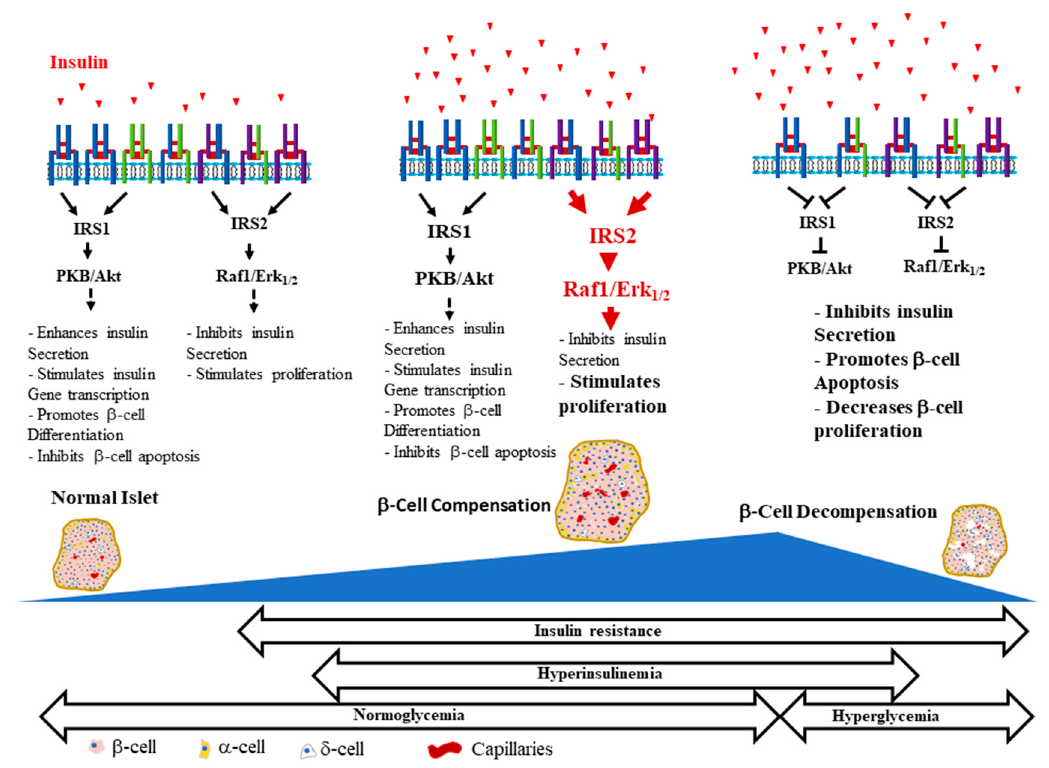
Figure 2. β -Cell life and death in the development of the obesity-mediated type 2 diabetes mellitus (T2DM). A simplified representation of the possible events involved in β -cell health and disease during the life time of a β -cell. The essential roles of insulin and IGF-1 signaling pathways in β -cell function and mass are depicted and the deleterious effects of their dysregulation are described. We included hyperinsulinemia, a key culprit factor that is often overlooked, which we believe might contribute to the common defects in the insulin and IGF-1 signaling pathways at the periphery and in islet β -cells that lead to the development of T2DM.